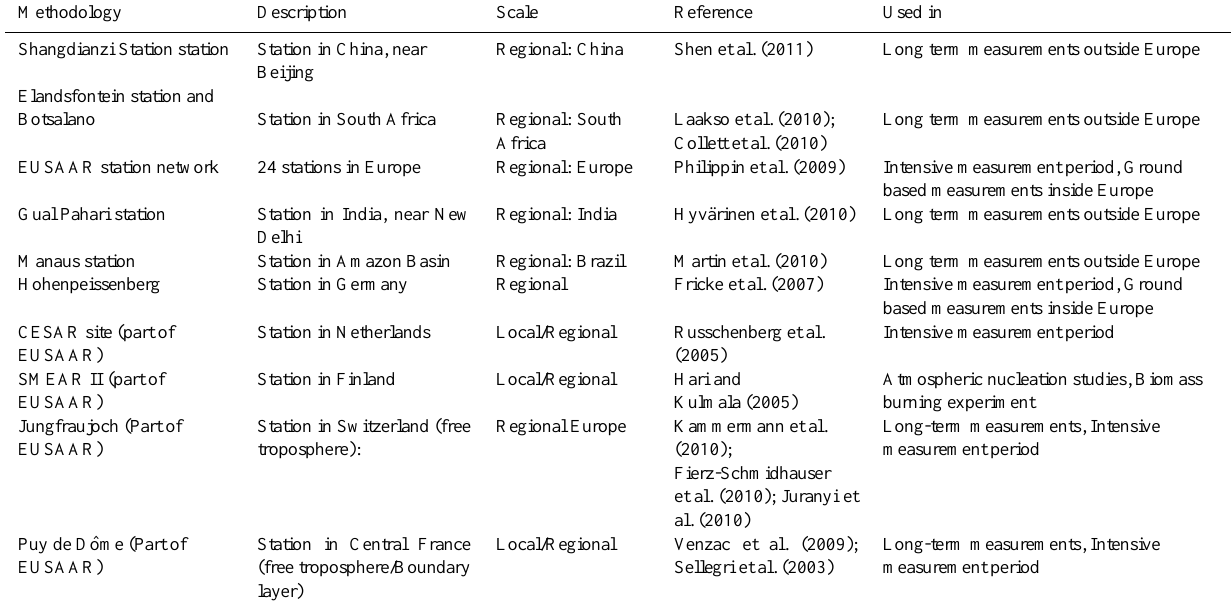
Table A2. Field infrastructures used in